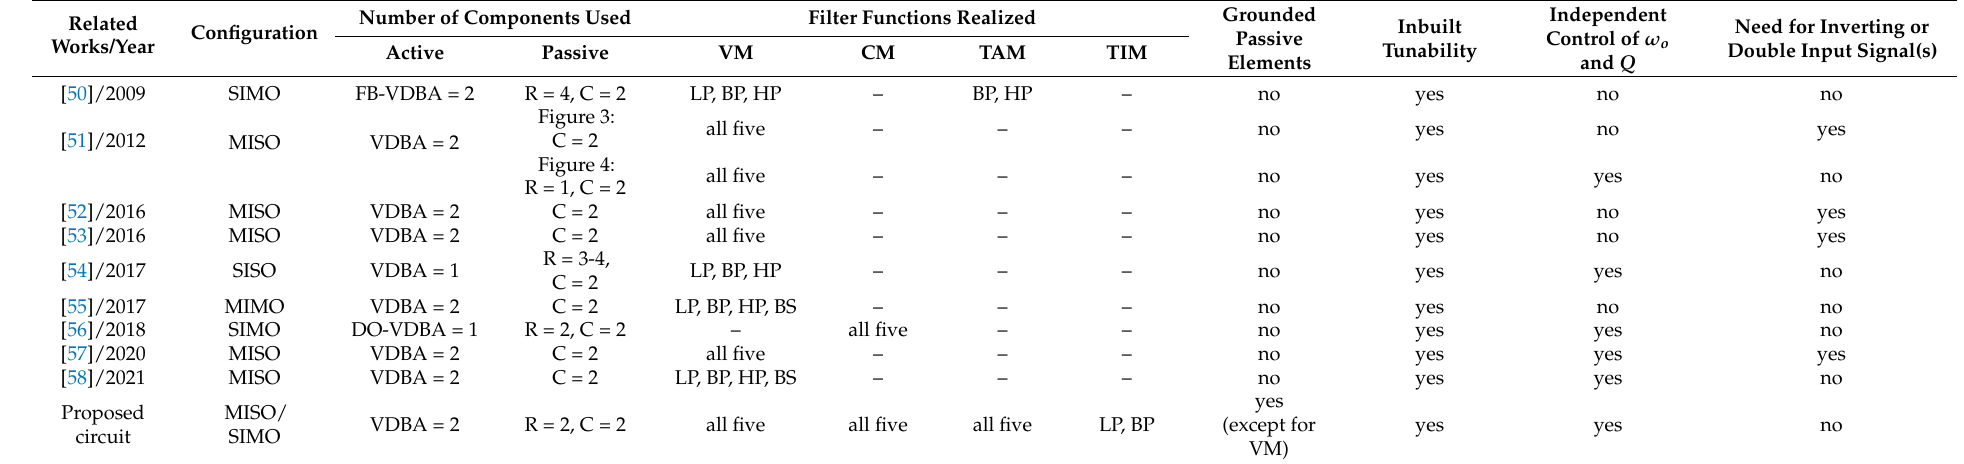
Table 2. Performance comparison of the proposed filter with the recently proposed VDBA-based biquad